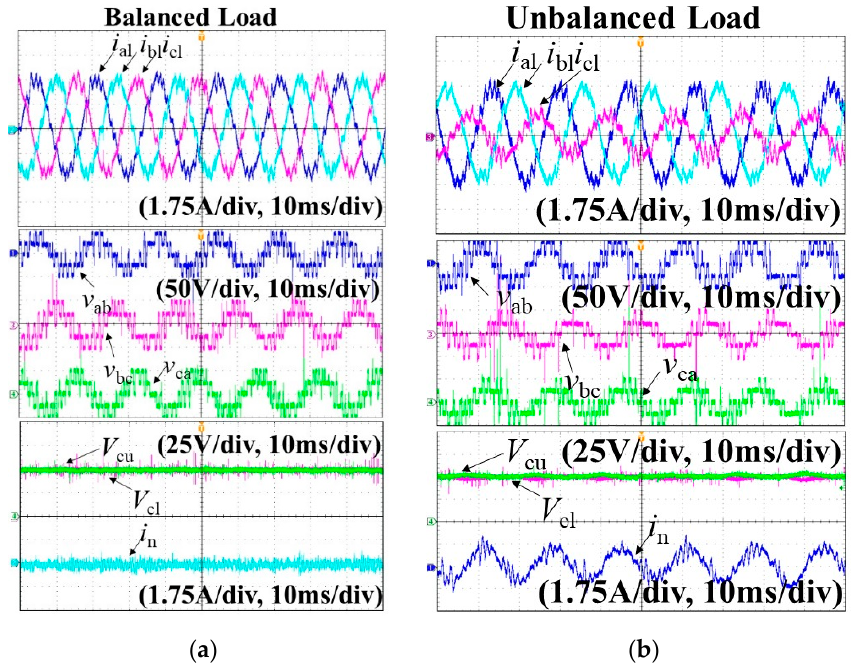
Figure 8. Experiment output performance of a three-level four-leg inverter with model predictive control under ( a ) balanced and ( b ) unbalanced load conditions.